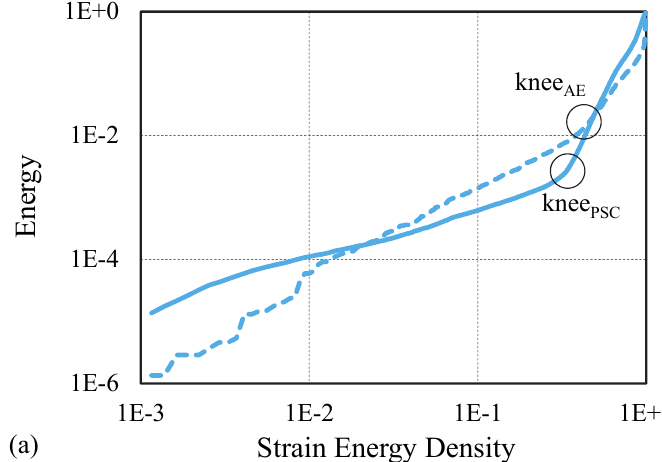
Figure 5: The energy calculated by both PSC and AE techniques versus the strain energy density for a typical specimen of (a)